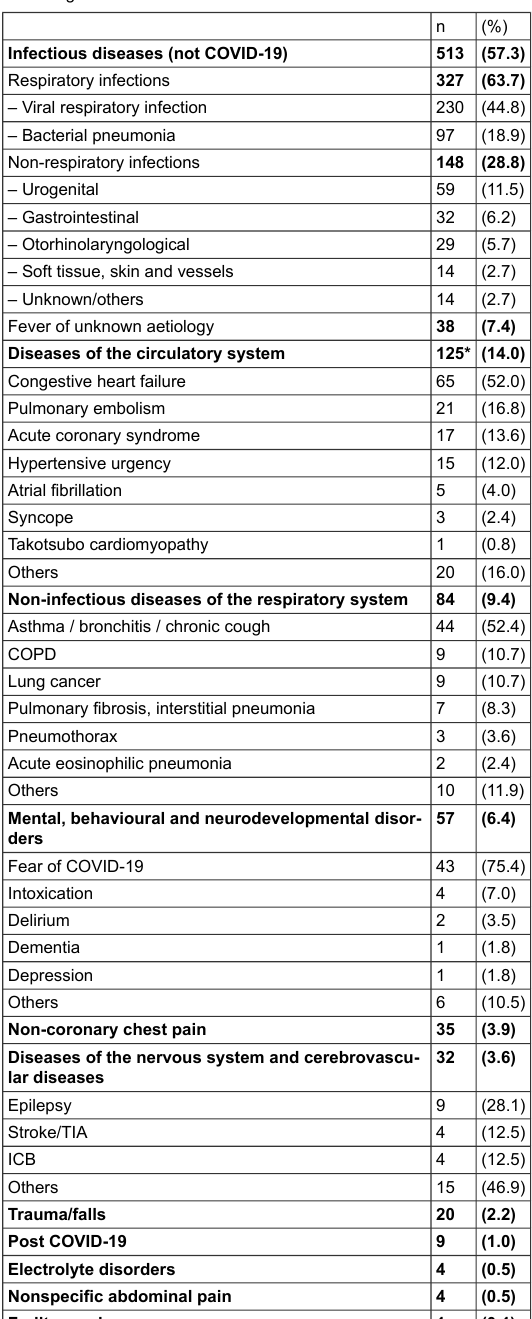
Table 4: Main diagnoses of COVID-19